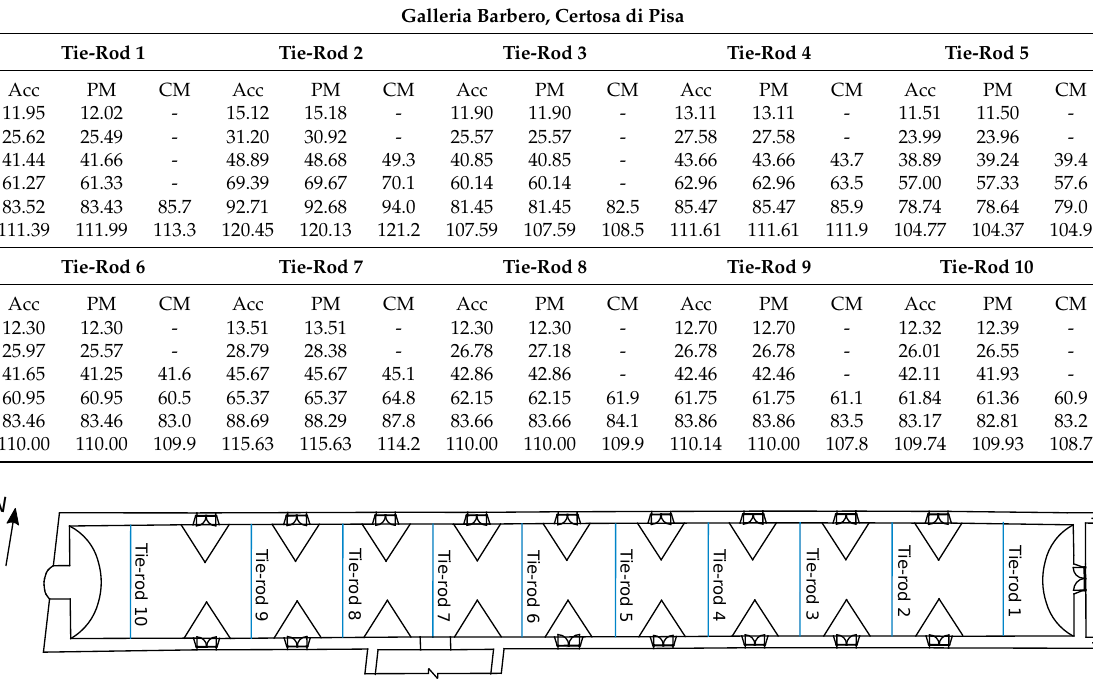
Figure 13. Plan of the Galleria Barbero in the Certosa di Pisa: the tested tie-rods are indicated.